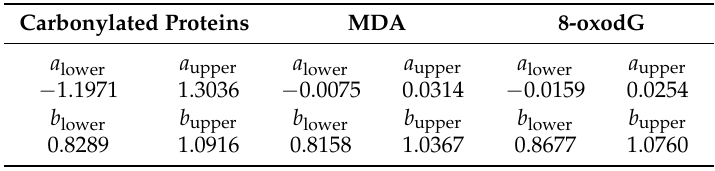
Table A8. Slope and intercept values for oxidative stress markers statistical